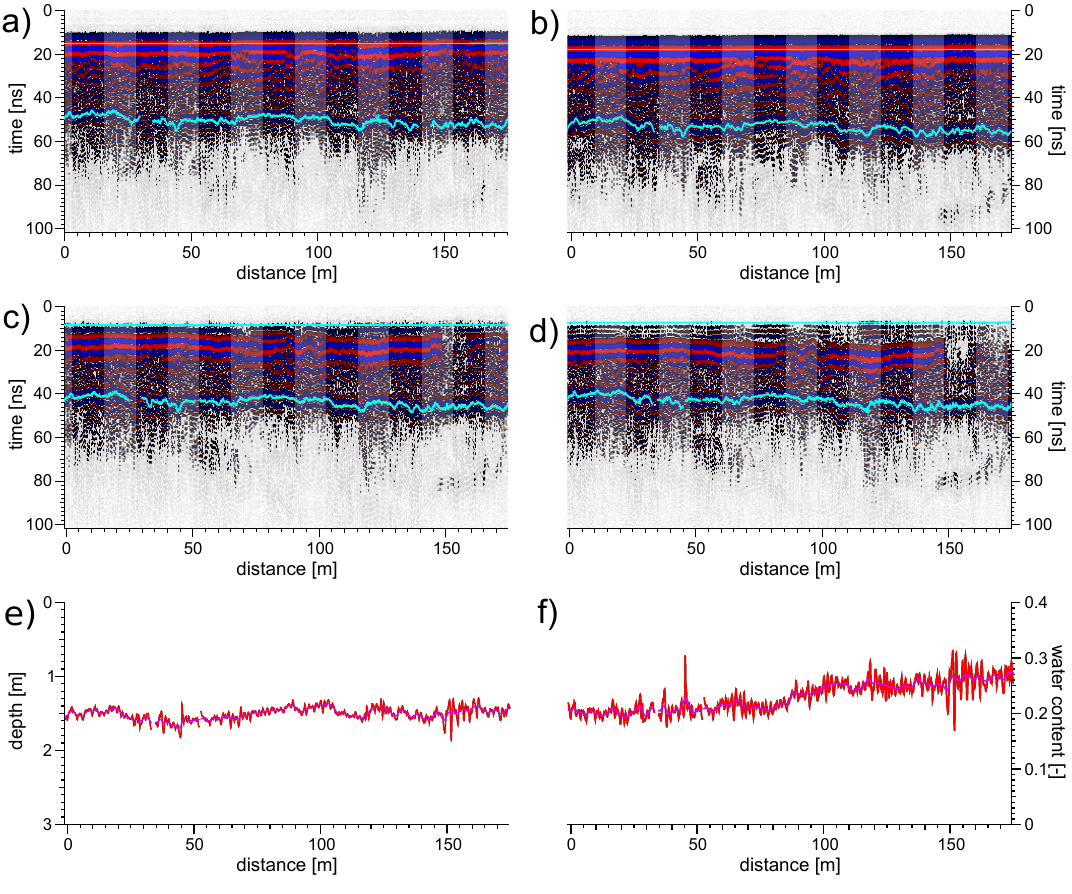
Fig. 3. Transect T2: Radar traces of all four channels and resulting evaluation on 15 August 2008. (a) and (b) : antenna separation 0.31m; (c) 1.07m; (d) 1.69m; (e) and (f) resulting thaw depth and volumetric soil water content (red: raw data; purple: smoothed